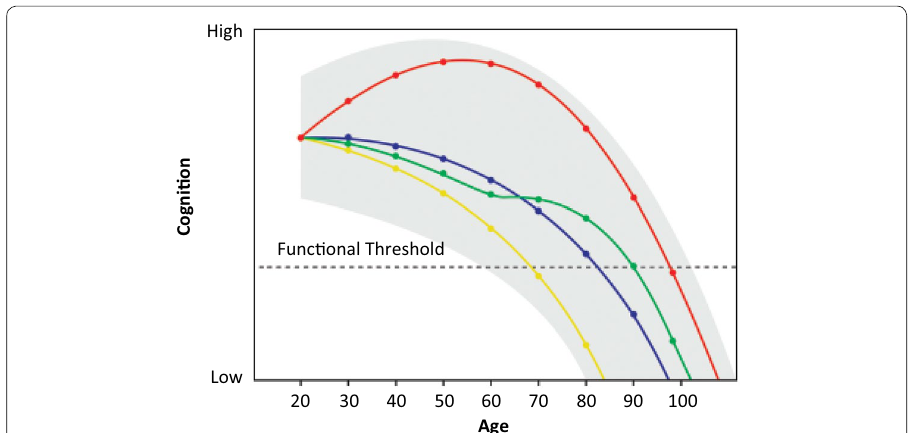
Fig. 5 Schematic representation of the possible trajectories of the evolution of an individual’s level of cognition (cognitive skills) by age. Source: Hertzog et al.